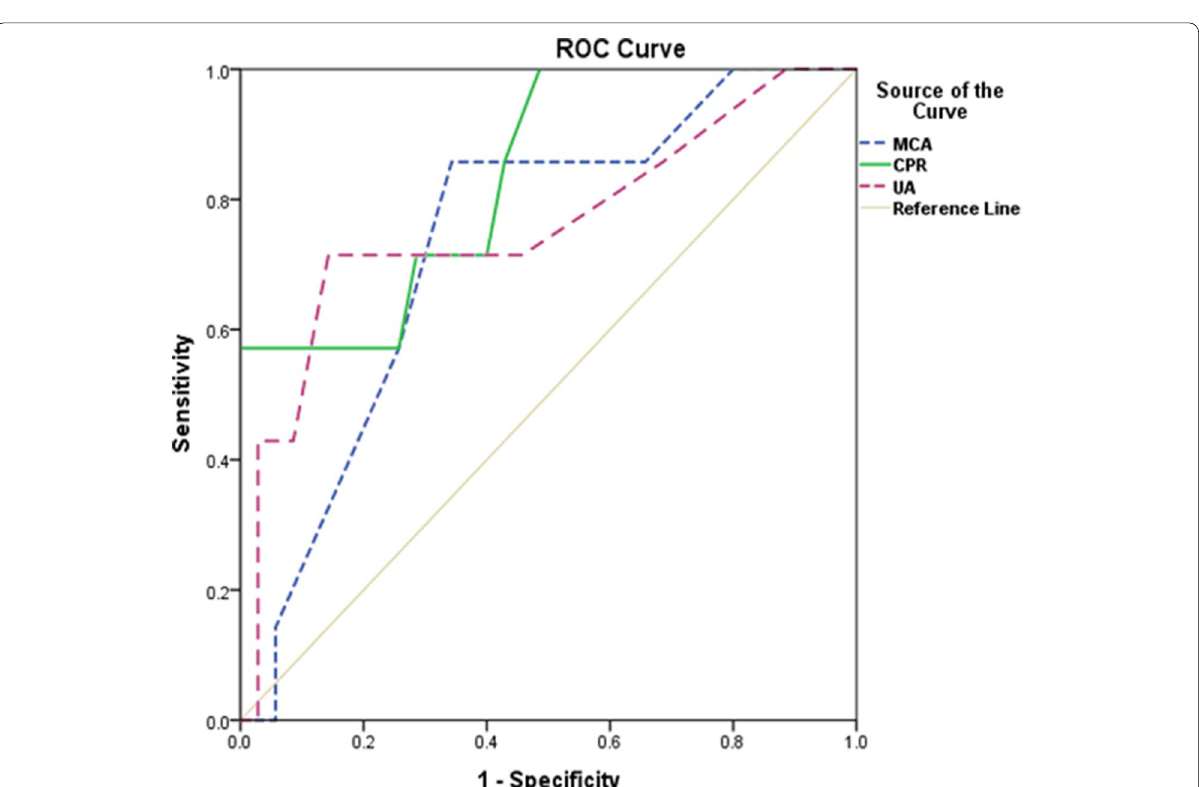
Fig. 2 Receiver–operating characteristics curves for prediction of cesarean section for intrapartum fetal compromise using cerebroplacental ratio, umbilical artery, and fetal middle cerebral artery pulsatility